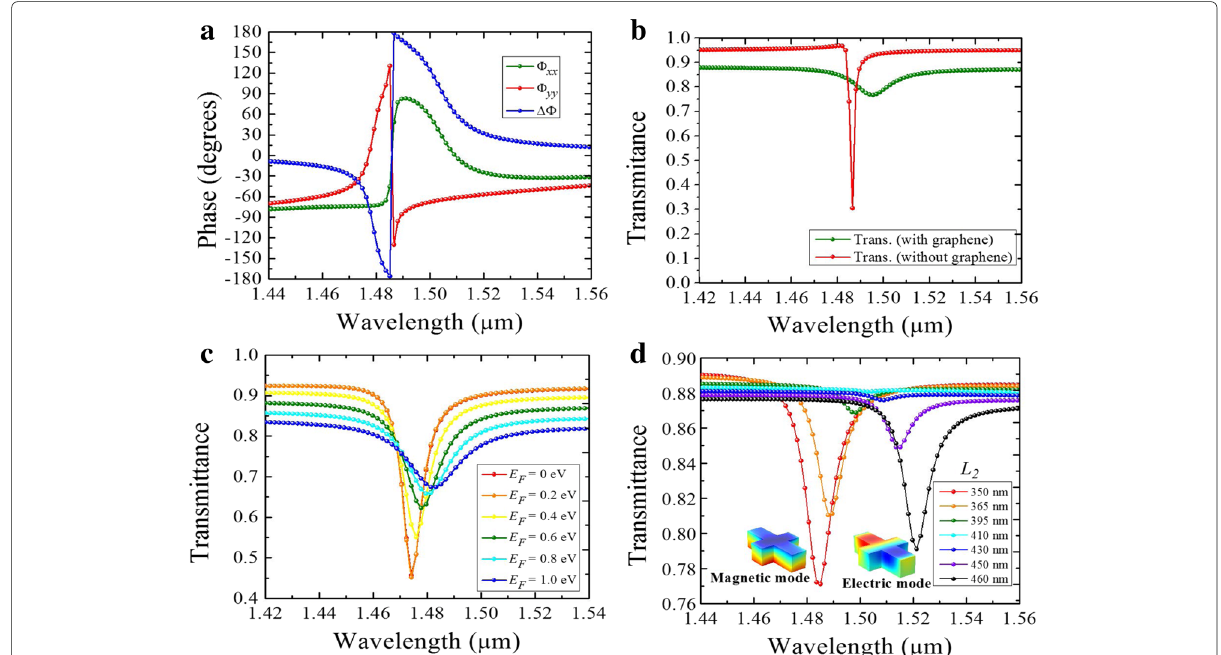
Fig. 3 a Phase components and retardation of an all-dielectric metasurface without graphene. Transmittance plotted as a function of wavelength for L 1 = 440 nm, L 2 = 370 nm, and W = 60 nm, for b structure without graphene and with graphene ( E F = 0.8 eV ) , c varying Fermi energy, and d varying L 2 from 350 to 450 nm. Symmetry breaking at L 2 = 410 nm splits two dominant modes: magnetic and